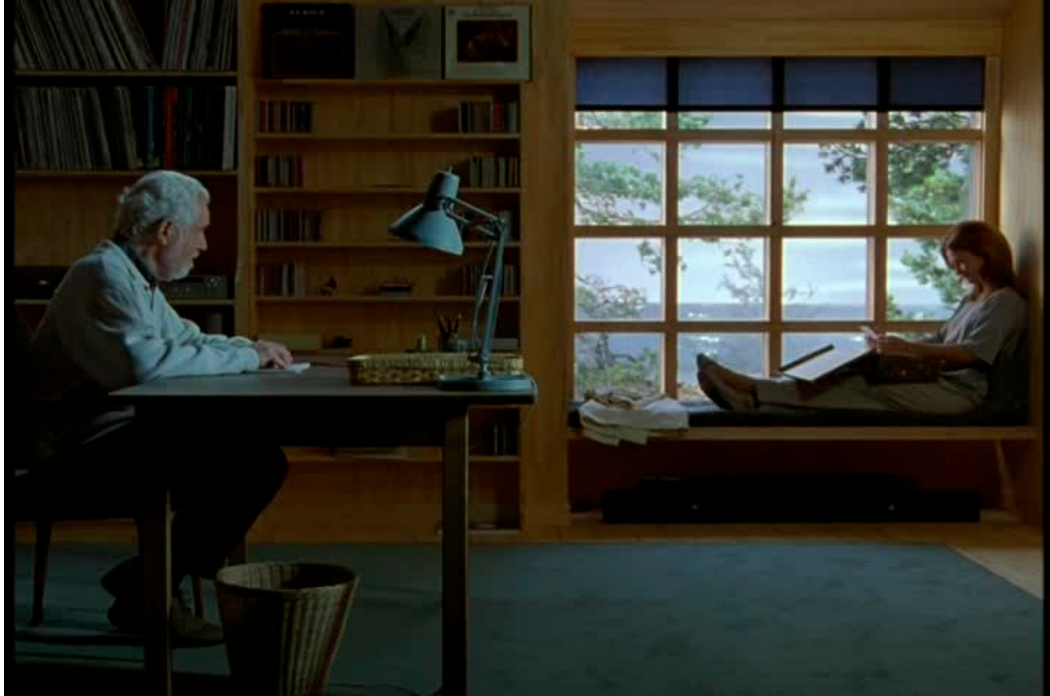
Figure 1. Bergman and Marianne write her story.